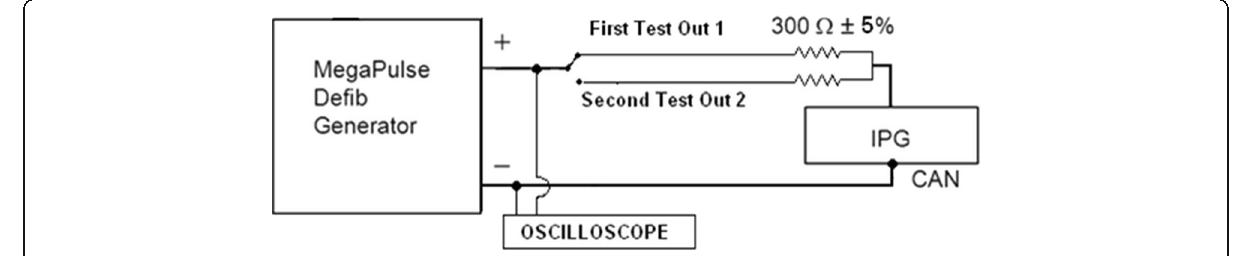
Fig. 2 Schematic diagram of defibrillation test